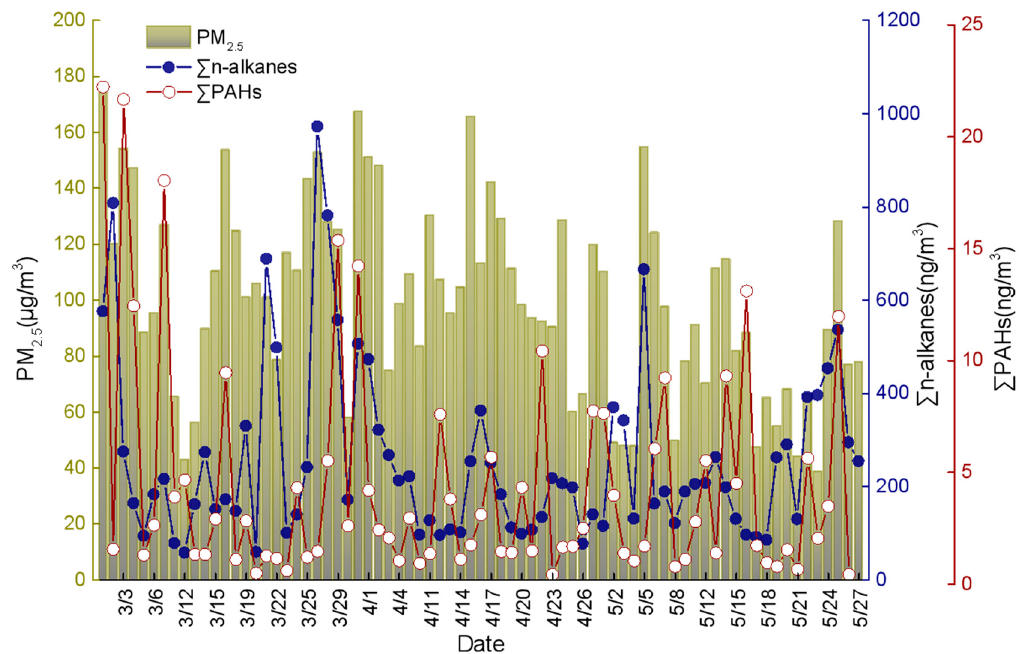
Figure 2. Time series of concentrations of PM 2.5 , ∑ n-alkanes and ∑ PAHs in spring in Changzhou. The chemical mass closures of PM 2.5 during three stages were calculated and pre- sented in Figure 1. For mass reconstruction, seven components [36] were considered, i.e., (1) organic matter (OM), calculated as OC × 1.6; (2) EC; (3) non-sea-salt sulphate (nss- SO 42 − ), evaluated as SO 42 − − 0.231 × Na + ; (4) nitrate (NO 3 − ); (5) ammonium (NH 4+ ); (6) sea salt (SS), estimated as Cl − + 1.4486 Na + ; and (7) dust ((Ca 2+ − 0.038 × Na + ) × 5.6). About 74–85% of PM 2.5 mass was identified. From Figure 1, it was evident that SNA were the most-abundant components of PM 2.5 , accounting for 29.4%, 30.9%, and 38.4% of PM 2.5 mass in severely polluted, polluted, and non-polluted days, respectively. Sea salts comprised a relatively small percentage (2–4%). For more details, the percentages of NO 3 − and NH 4+ showed a slight change in the three pollution levels, but the mass of nss-SO 42 − , which was attributed to the chemical reactions of SO 2 in the atmosphere, caused by fossil age change from severely polluted (7.5%) to non-polluted (13.8%) days, showing the higher OM was the second-largest component during the three periods. With the increase in PM 2.5 period to 20.3% on the severely polluted days. The proportion of dust showed a marked decline from the severely polluted (16.2%) to non-polluted period (11.2%).